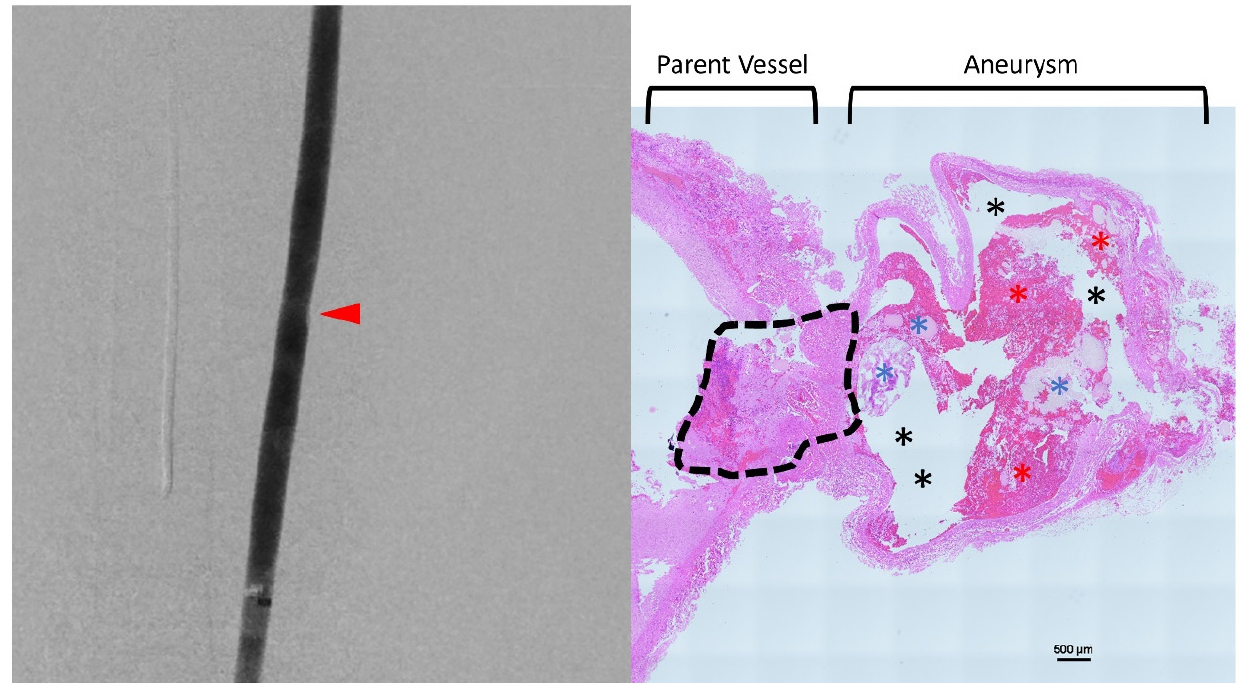
Figure 5. Follow-up angiography of the common carotid artery ( left ) showing complete obliteration of the aneurysm (red arrow). Histopathology ( right ) of the parent vessel and thrombosed aneurysm also shown, showing PHP (blue asterisks) and chronic thrombus (red asterisks) within the aneurysm, along with a preparation artefact (black asterisks) and robust endothelialization over the neck (within dotted line).